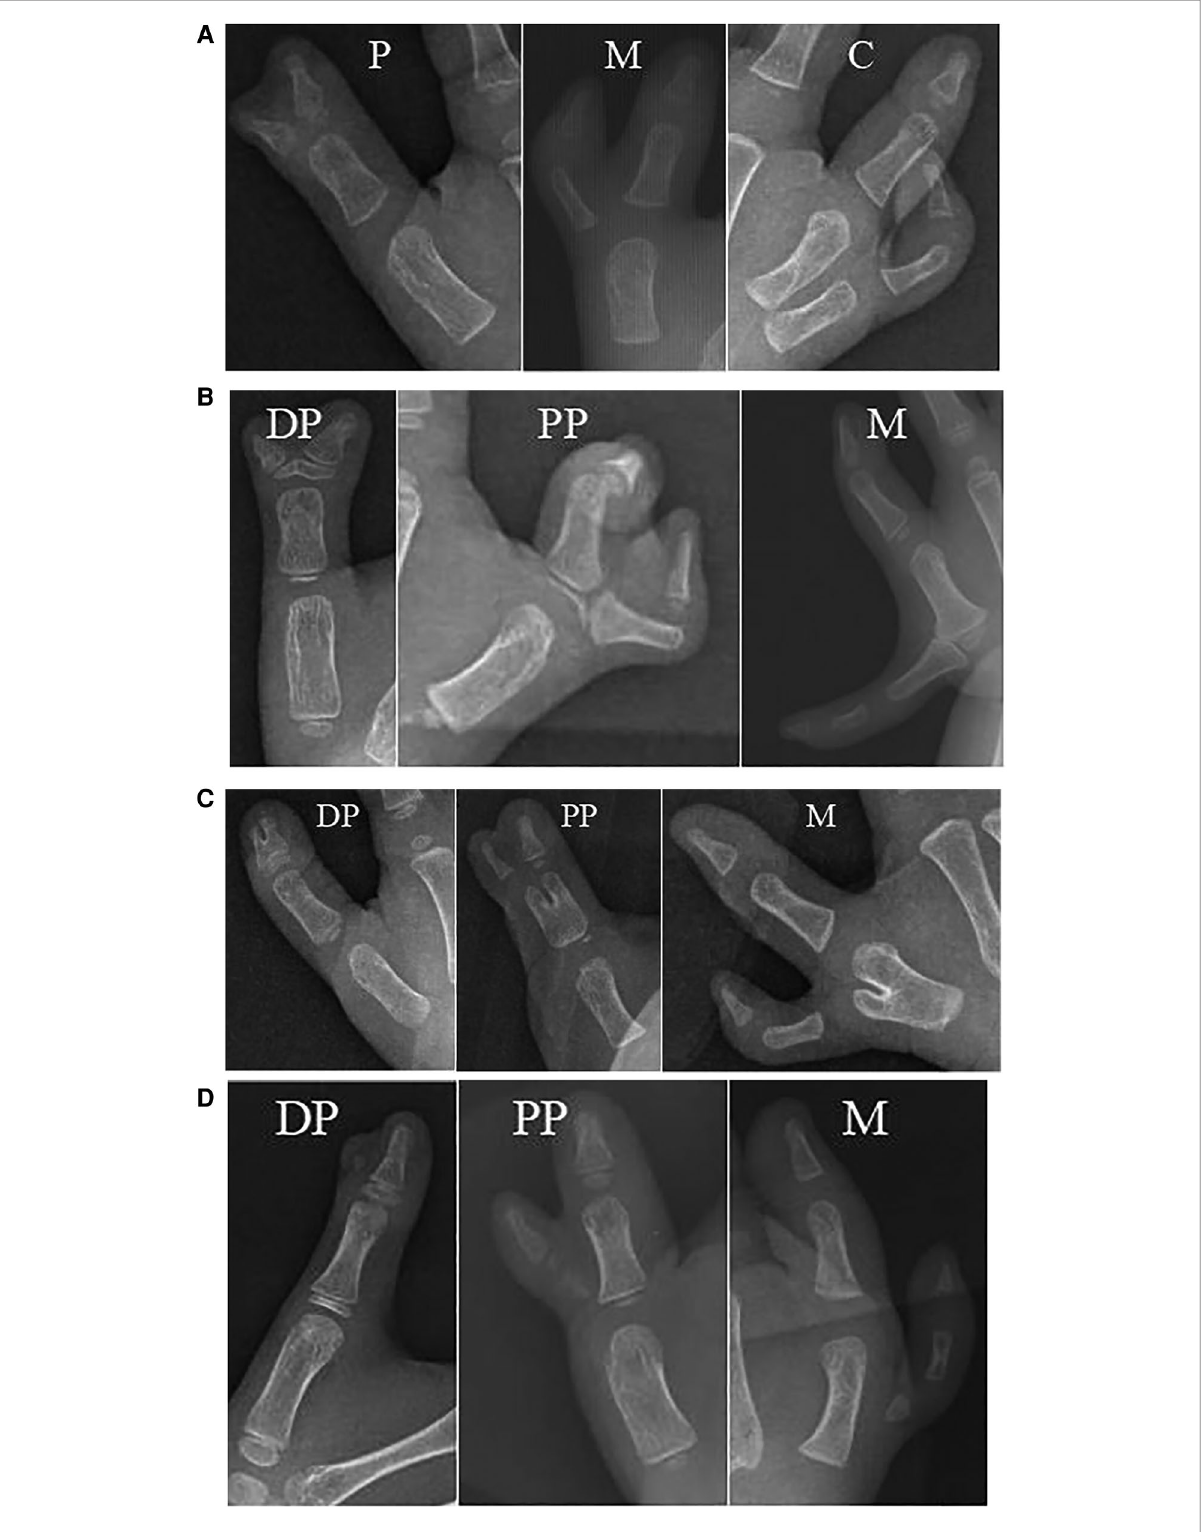
FIGURE 3 ( A – D) Radiograph of the Chung et al. Classi fi cation. ( A ) type A-P, A-M, A-C; ( B ) type B-DP, B-PP and B-M; ( C ) type C-DP, C-PP and C-M; ( D ) type D- DP, D-PP and D-M. P, phalanx; M, metacarpal; C, carpal; DP, distal phalanx; PP, proximal